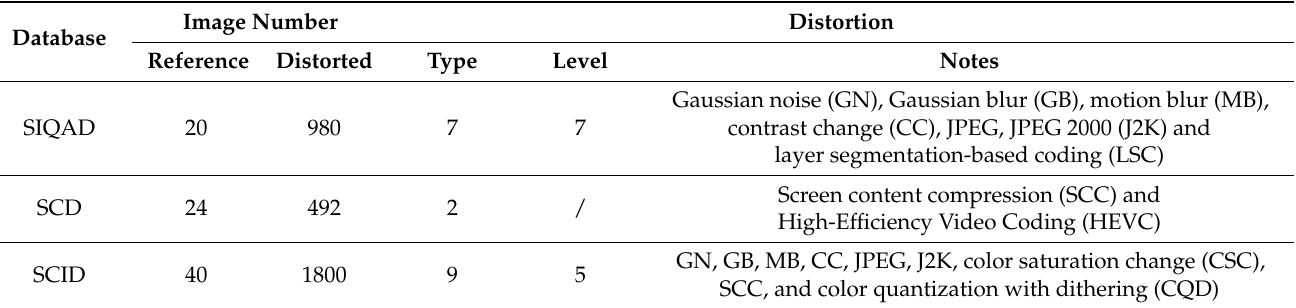
Table 1. Brief introduction of three public SCI